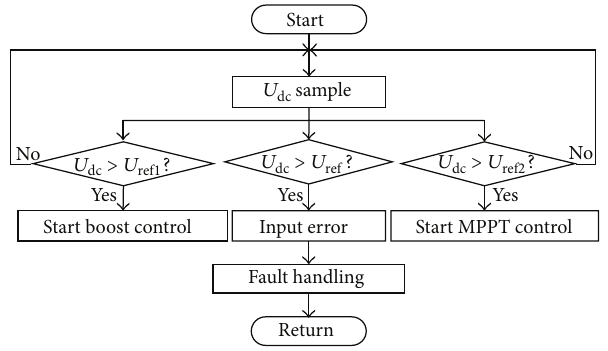
Figure 2: The DC/DC control flow